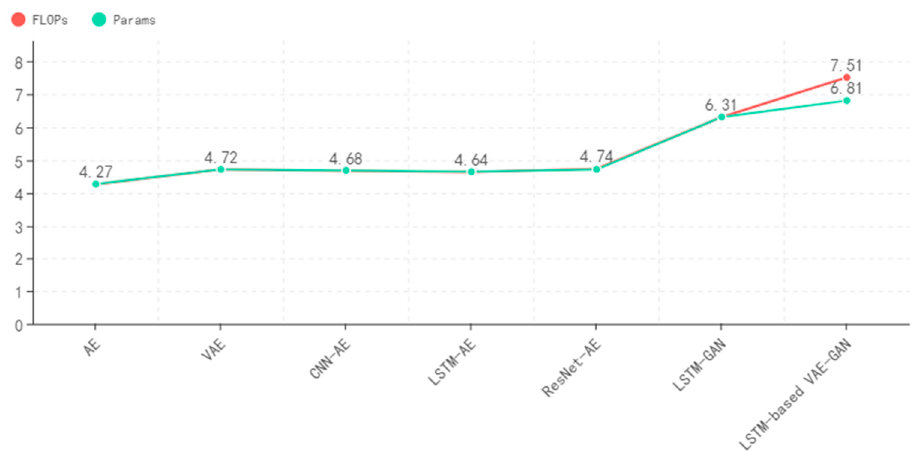
Figure 11. Complexity analysis of common anomaly detection models.